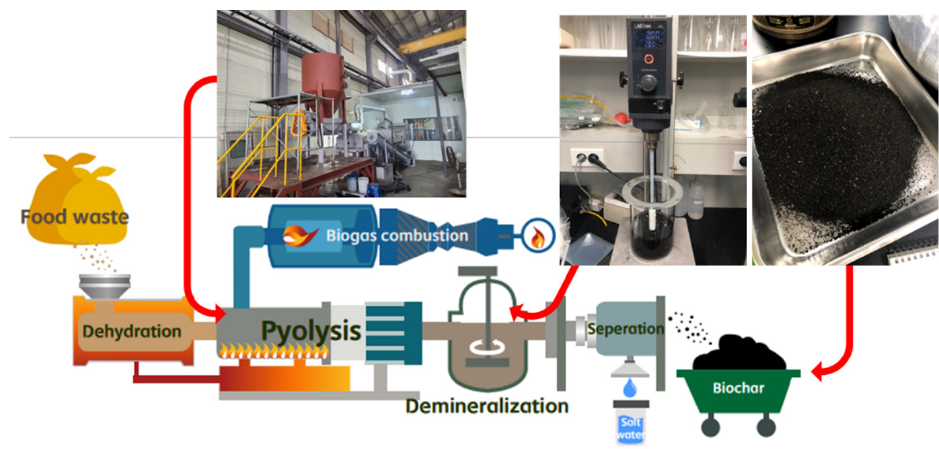
Figure 1. Experiment scheme and photos from food waste to biochar.